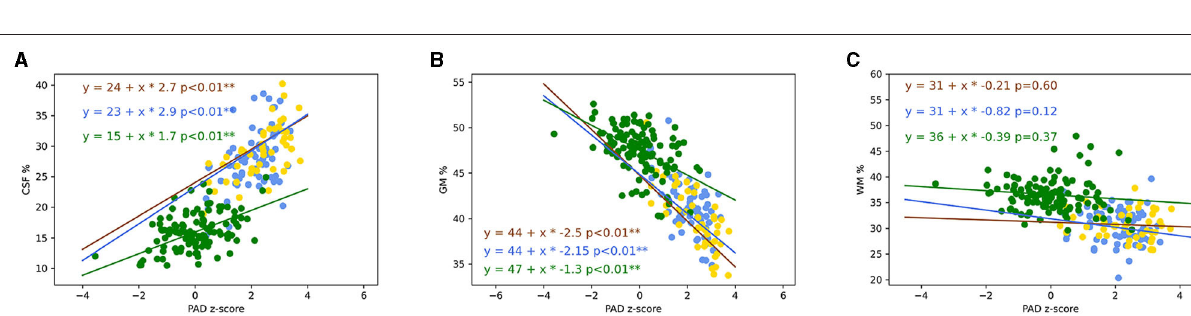
FIGURE 6 | (A) Plot of the MMSE in function of PAD in the EOAD population. (B) Plot of the CDR-SB in function of PAD in the EOAD population. Lines represented linear trajectories using linear regression model (blue line: amnestic EOAD and yellow line: non-amnestic EOAD). ** p < 0.05. MMSE, Mini-Mental State Examination; PAD, predicted age difference; CDR-SB, Clinical Dementia Rating Sum of Boxes; EOAD, early-onset Alzheimer’s disease.